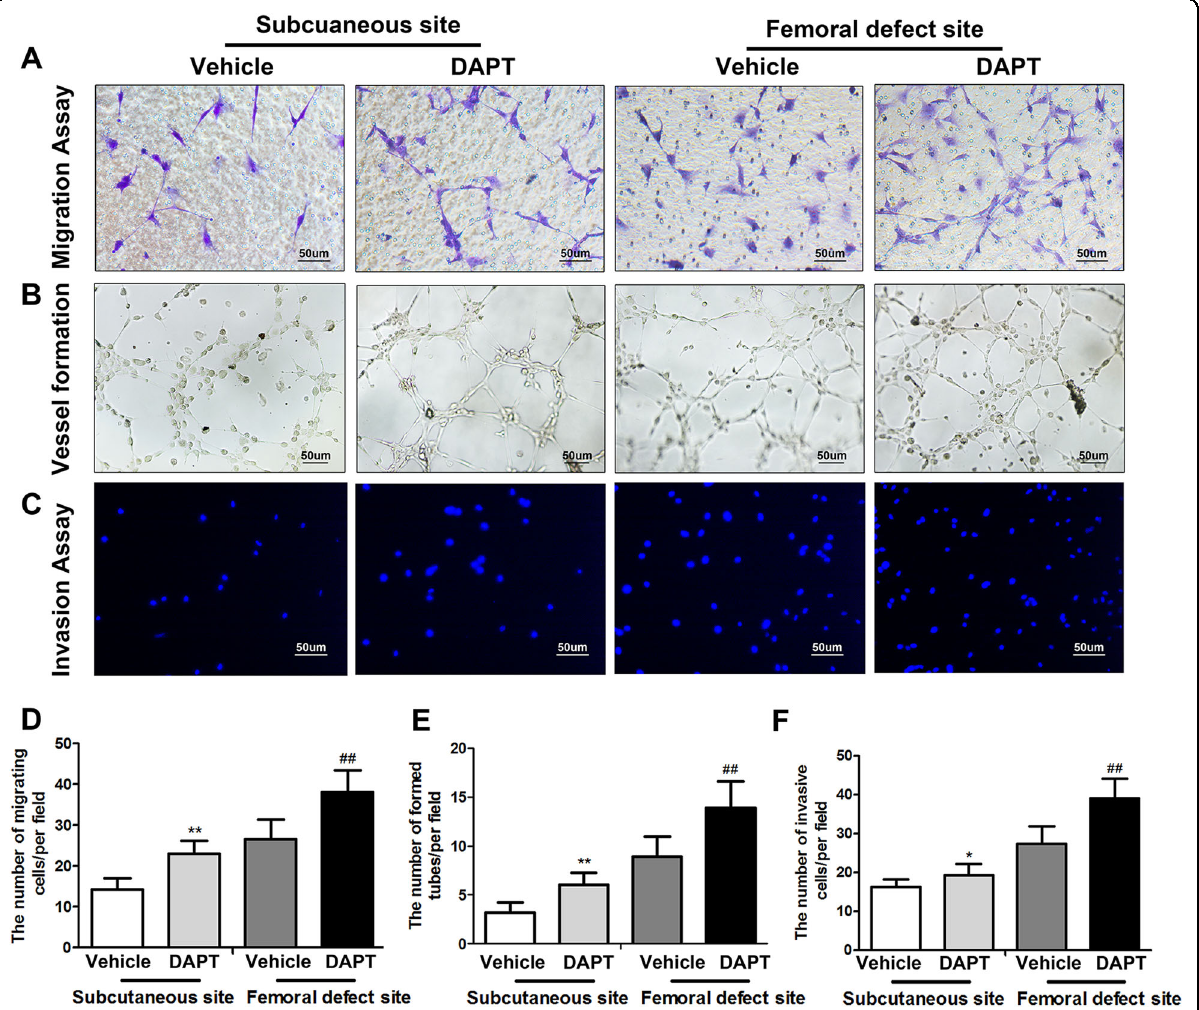
Fig. 8 DAPT-modi fi ed induced membrane promotes migration, invasion and angiogenesis of EPCs. a , d A Boyden chamber assay was used to evaluate the effect of different induced membranes on EPC migration. Migrated cells were stained with crystal violet and quantitated in fi ve randomly selected fi elds (scale bar: 20 μ m). b , e An in vitro angiogenesis assay was used to investigate the effects of the different induced membranes on EPC neovascularization. Representative photomicrographs and quantitative data showed the number of branch points in treated EPCs (scale bar: 50 μ m). c , f The invasive properties of EPCs treated with the different induced membrane proteins were evaluated in an invasion assay. Invasive cells were stained with DAPI and quantitated in fi ve randomly selected fi elds (scale bar: 50 μ m). The data in the fi gures represent averages ± S.D. Signi fi cant differences between the different groups are indicated as * P < 0.05, ** P < 0.01, compared with the corresponding groups in the saline-treated induced membrane in the subcutaneous site; ## P < 0.01, compared with saline-treated induced membrane in the femoral defect site; for each group, n =